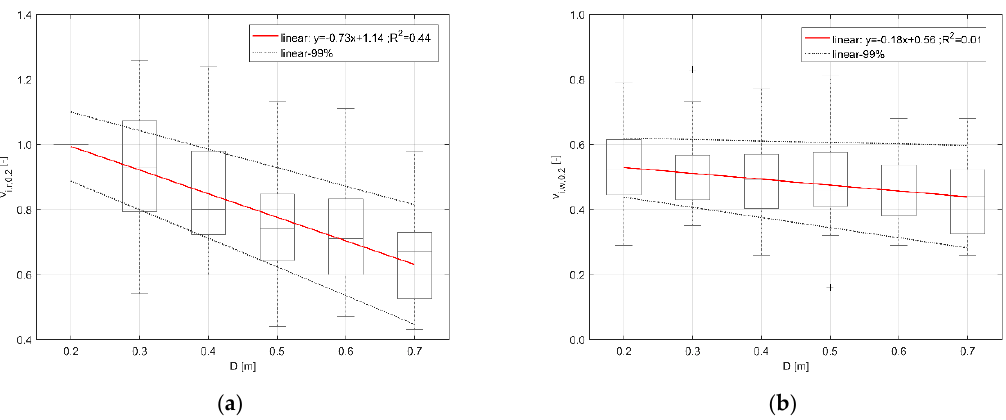
Figure 15. Normalized speed variation depending on D , by normalizing the speed values by v r, 0.2 (speed of the individual in minimum constraint and maximum excitement conditions within the tested D range): ( a ) for running conditions; ( b ) for walking conditions. Linear regressions (dashed lines refer to prevised values outside of the tested D range) and boundary conditions (99%) are shown.